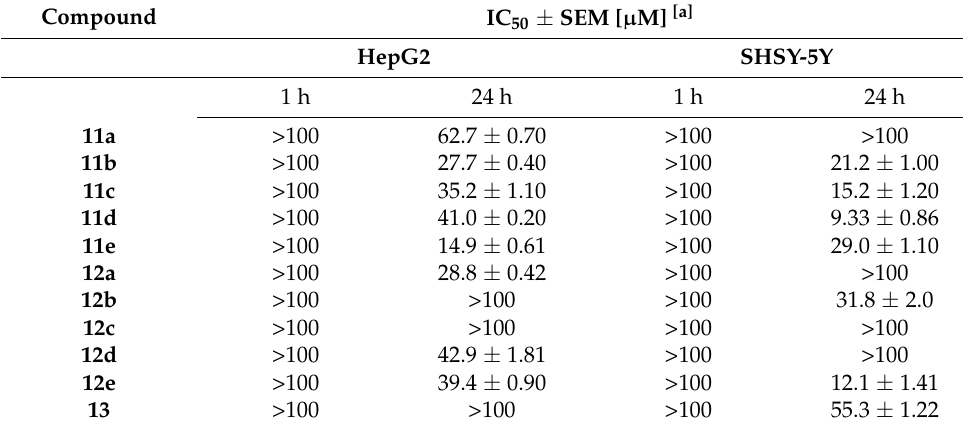
Table 4. IC 50 of compounds under study ( 11a–e , 12a–e , and 13 ) in the MTT cytotoxicity assay on HepG2 and SHSY-5Y cells after 1 h or 24 h of